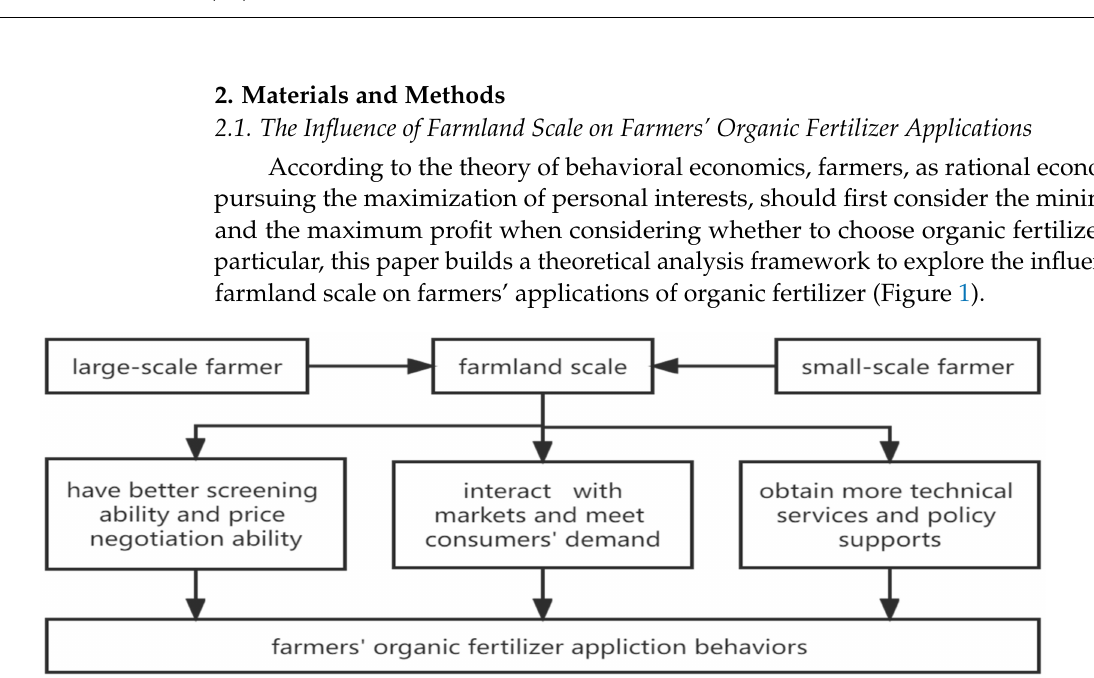
Figure 1. Analytical